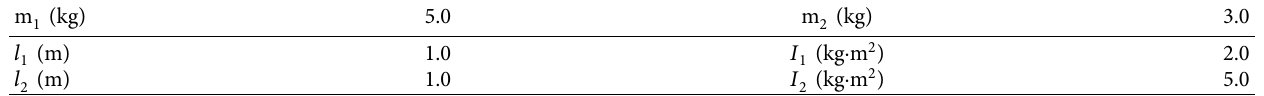
Table 1: Simulation parameters of the manipulator in Figure